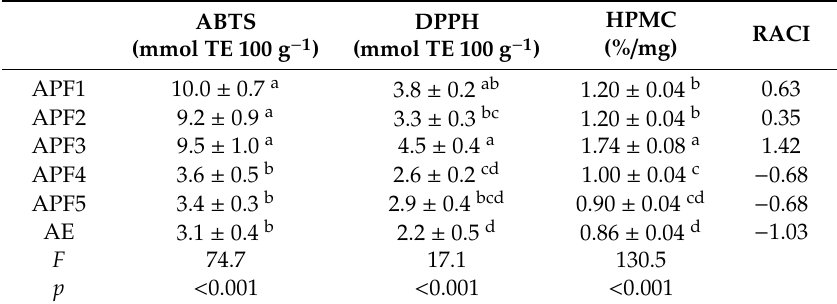
Table 3. Antioxidant activity of APF1–5 and AE determined by ABTS, DPPH and HPMC as well as Relative Antioxidant Capacity Index